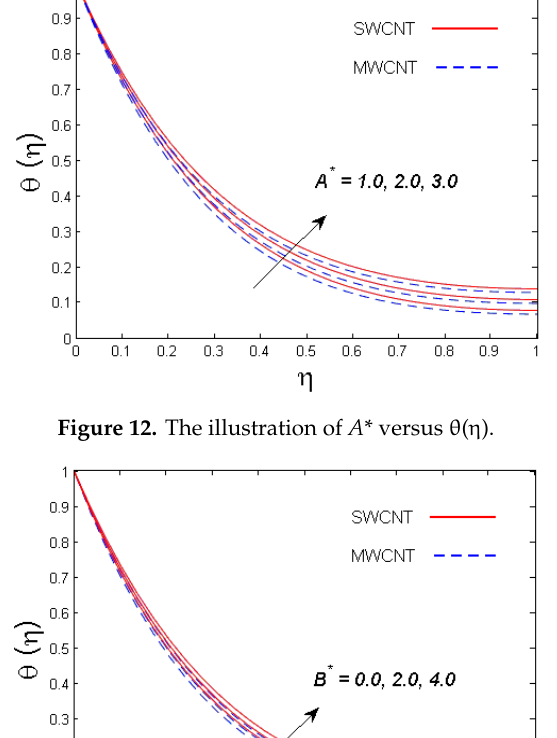
Figure 11. The illustration of R versus θ(η).